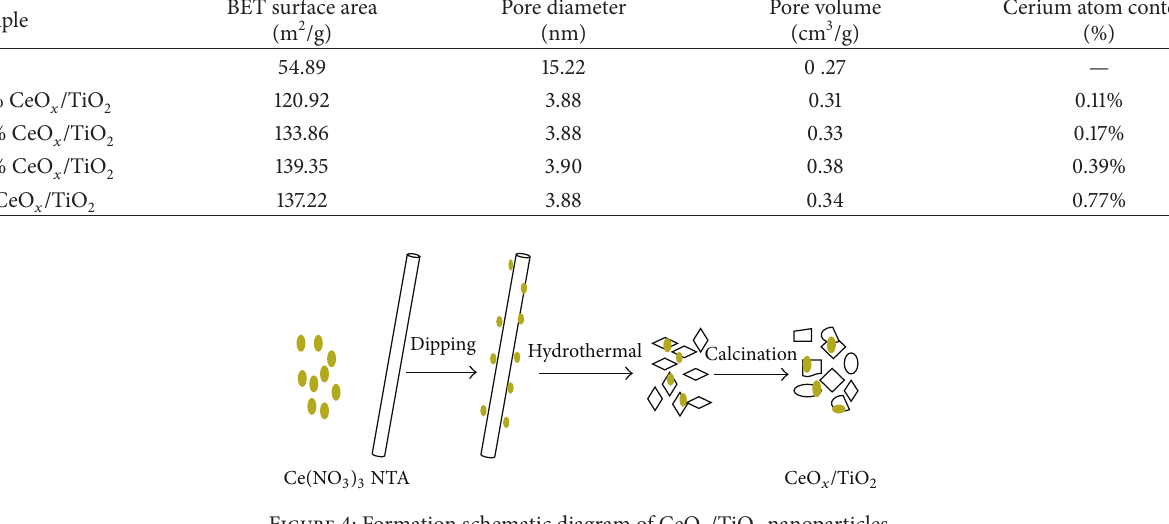
Figure 4: Formation schematic diagram of CeO 𝑥 /TiO 2